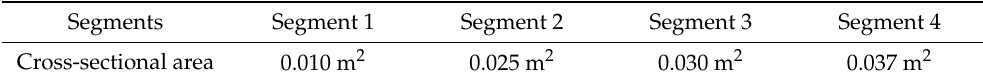
Table 3. Cross-sectional area of the segmented space elevator system.